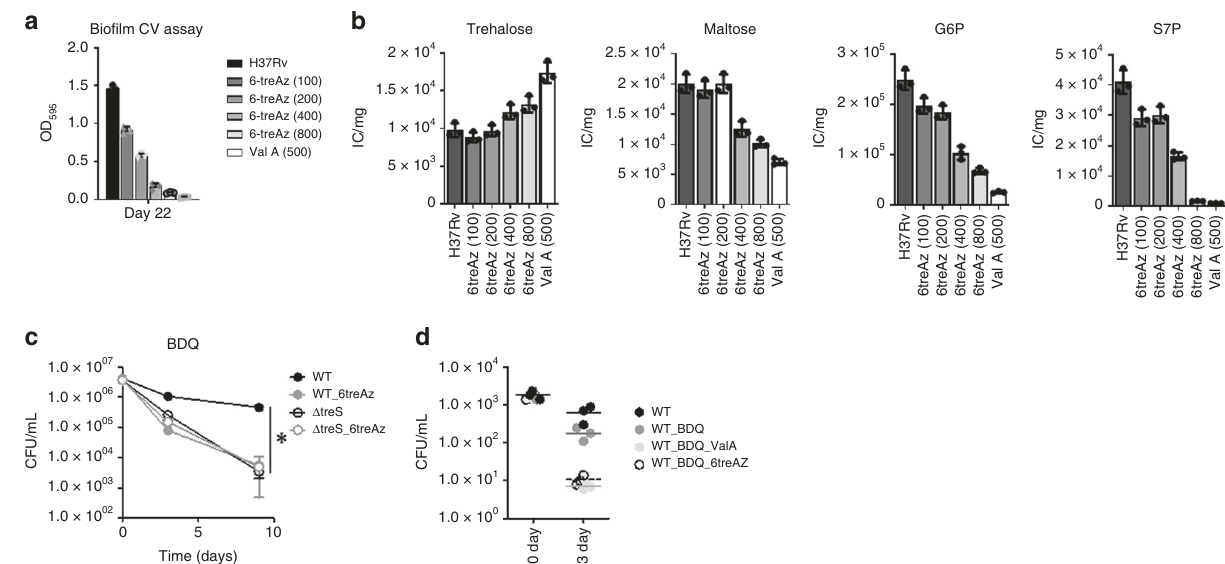
Fig. 5 Anti-PLB formation activity of 6-azido-6- α , α ′ -trehalose (6-treAz). a The effects of various concentrations (100 – 800 µ M) of 6-treAz treatment on PLB formation were monitored by CV staining assay of PLB harvested at day 28 of mycobacterial bio fi lm culture. Treatment with 500 µ M validamycin A was included as a positive control. b Metabolic impact of various concentrations of 6-treAz on PLB metabolism. The metabolome of PLB was harvested at day 28 PLB within mycobacterial bio fi lm culture. Intrabacterial pool sizes of PLB intermediates in trehalose metabolism (trehalose and maltose) and GL (G6P) and PPP (S7P) following treatment with various concentrations of 6-treAz or 500 µ M Val A. c CFU-based viability of WT Mtb or Δ treS in the presence or absence of 200 µ M 6-treAz following co-treatment with 10× MIC equivalent of BDQ. d The effect of 6-treAz and/or Val A on CFU-based viability of WT Mtb inside human PBMC macrophages following treatment with 10× MIC-equivalent BDQ. All values are the average of biological triplicates ±s.e.m. * P < 0.001 by ANOVA with Bonferroni post-test correction. S7P, sedoheptulose 7-phosphates; G6P, glucose 6-phosphates. Source data are provided as a Source Data fi le